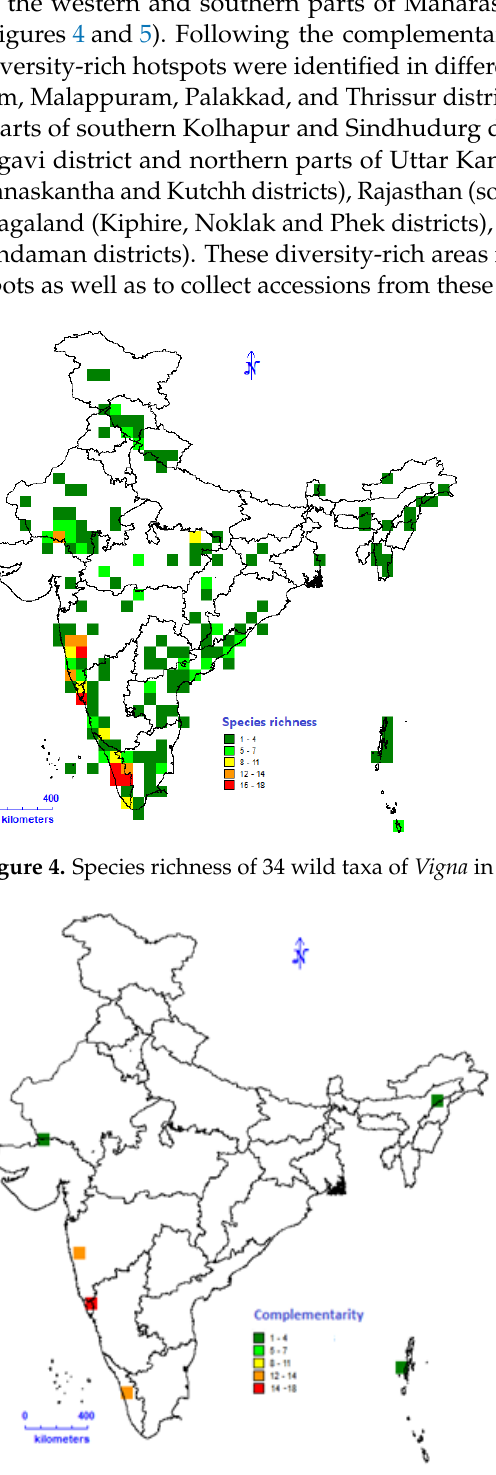
Figure 5. Diversity-rich hotspots for 34 wild taxa of Vigna identi fi ed using the complementarity technique.